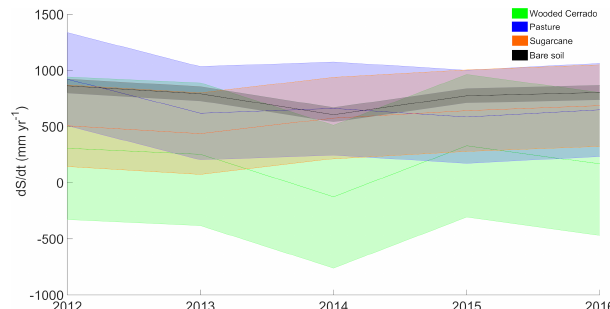
Figure 4. Annual water balance residual (d S/ d t ) for different LCLU types during 2012–2016 period; shaded areas indicate the standard error (uncertainties) of d S/ d t